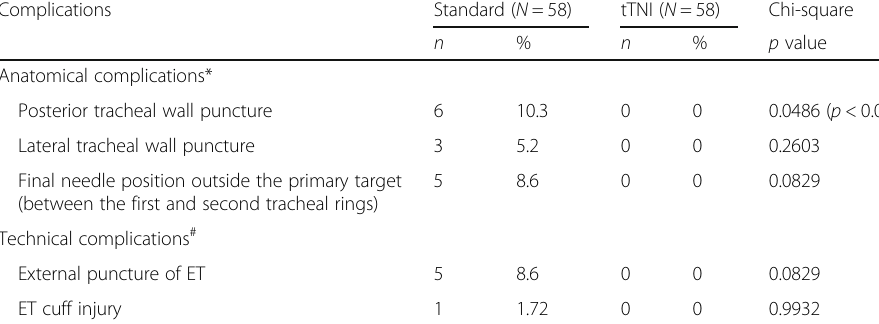
Technical complications # External puncture of